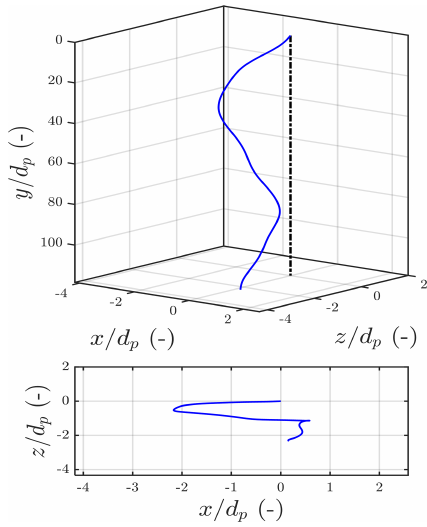
Figure 8. Calcite pellets = 2.36 <d p < 2.8, T = 20 ◦ C, C D = 0 . 57, ρ = 2 . 7, Re t = 800, Ga = 522, v t = 0 . 32, v t , BL = 0 . 34, an- gle = 2.1 ◦ , and − % v t = 8%, and path =